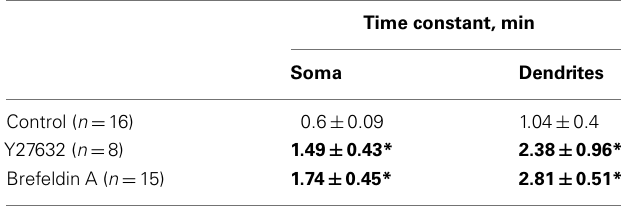
Table 1 | Modulation of P2X3 receptors turnover in soma and dendrites at 29˚C (the 21˚C data are omitted for